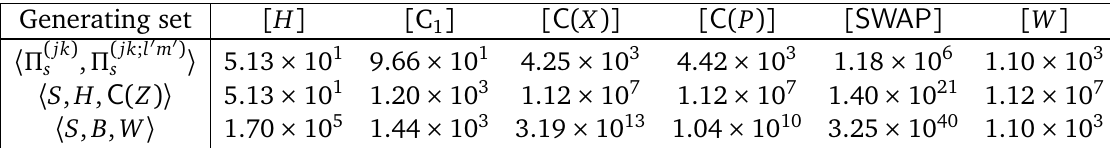
Table 4: Difficulty weights of Pauli cosets of gates for the case where Majorana- Pauli tracking methods are utilized for one-sided hexon architectures with the 〈 1,2,6,3,4,5 〉 labeling configuration. We compare the weights for gates syn- thesized from the generating sets of operations given by MZM measurements ( jk ; l (cid:48) m (cid:48) ) 〈 Π ( jk ) 〉 , Clifford gates 〈 S , H , C ( Z ) 〉 , or braiding operations 〈 S , B , W 〉 , , Π s s